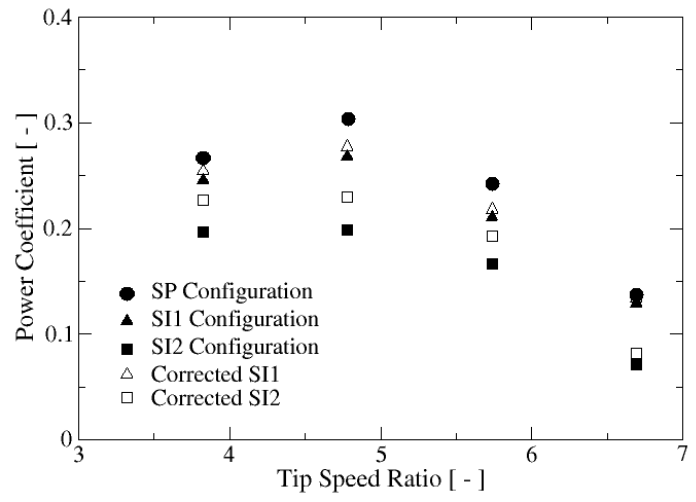
Figure 11. The power coefficient versus tip speed ratio for the different configurations.